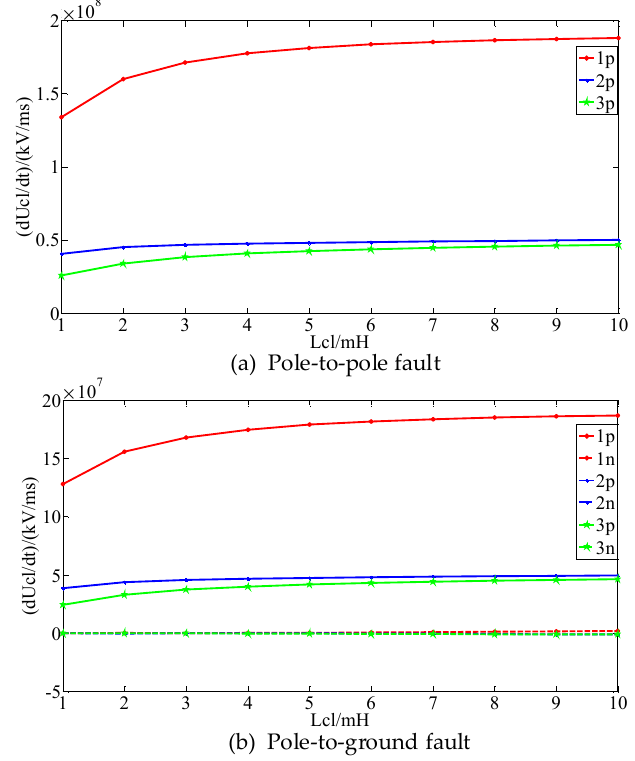
Figure 10. The influence of current-limiting inductance on the voltage change rates of the CLIs.